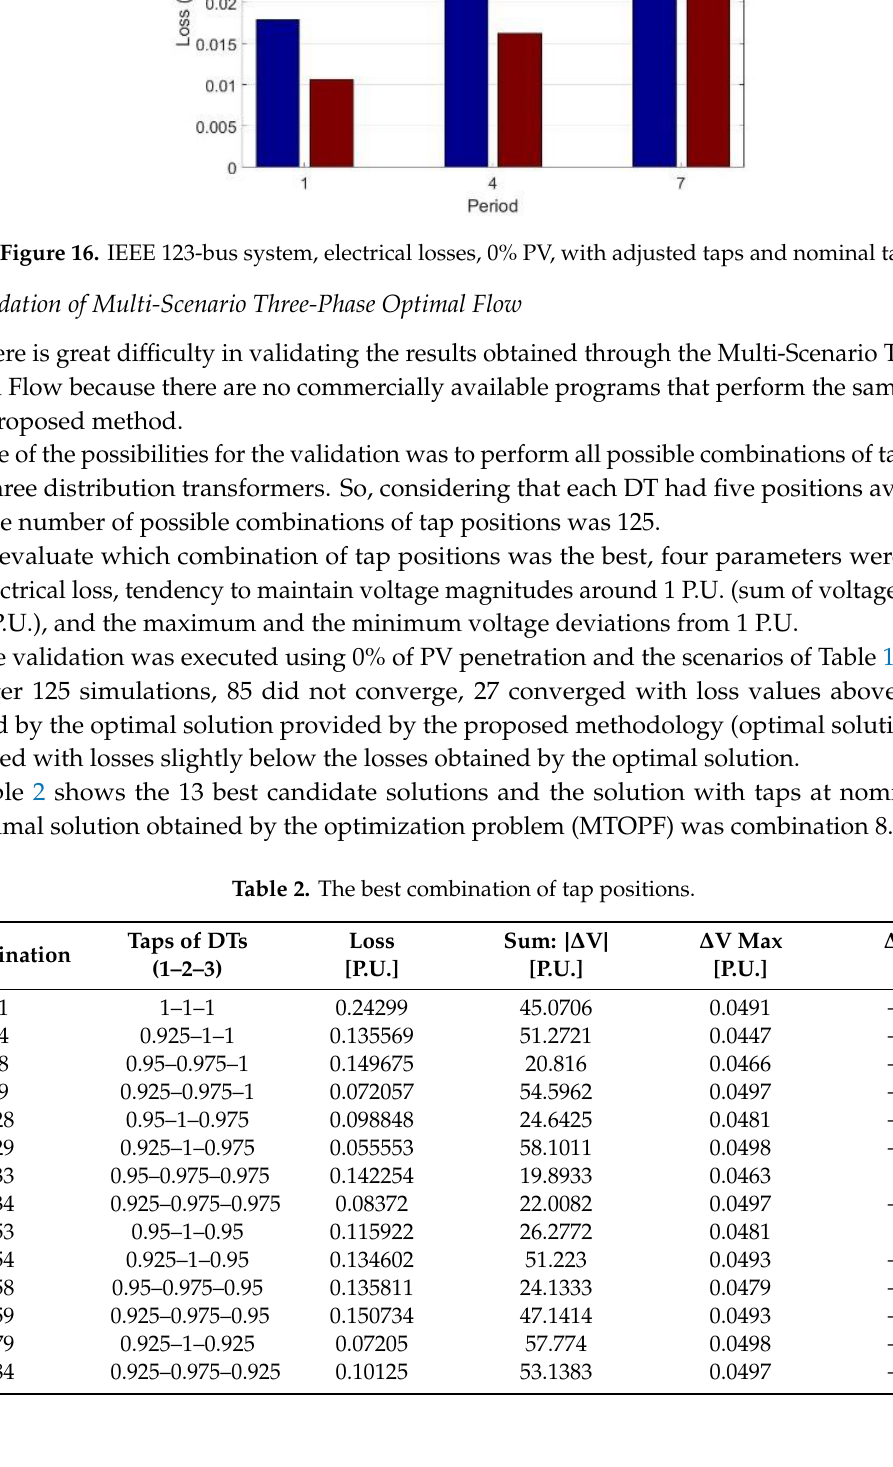
Table 2. The best combination of tap positions.